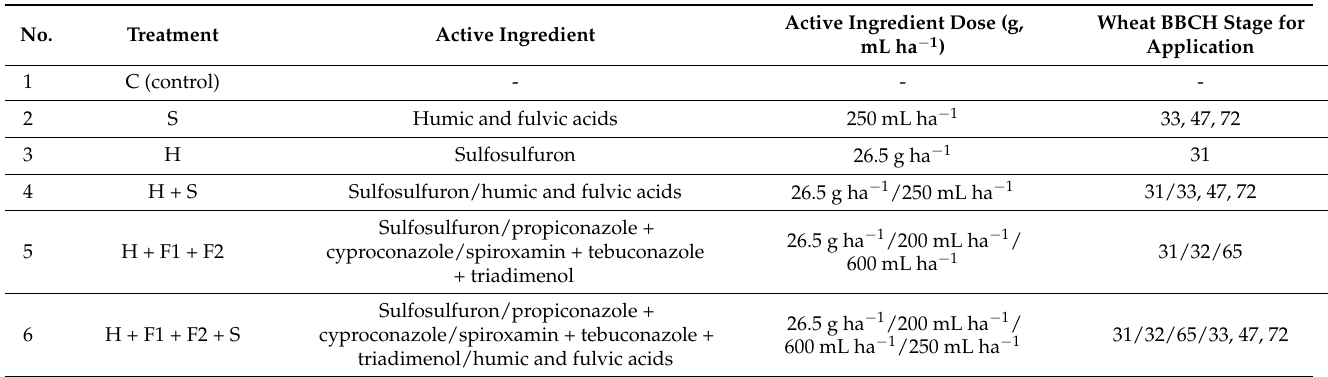
Table 1. Details of the treatments carried out in this